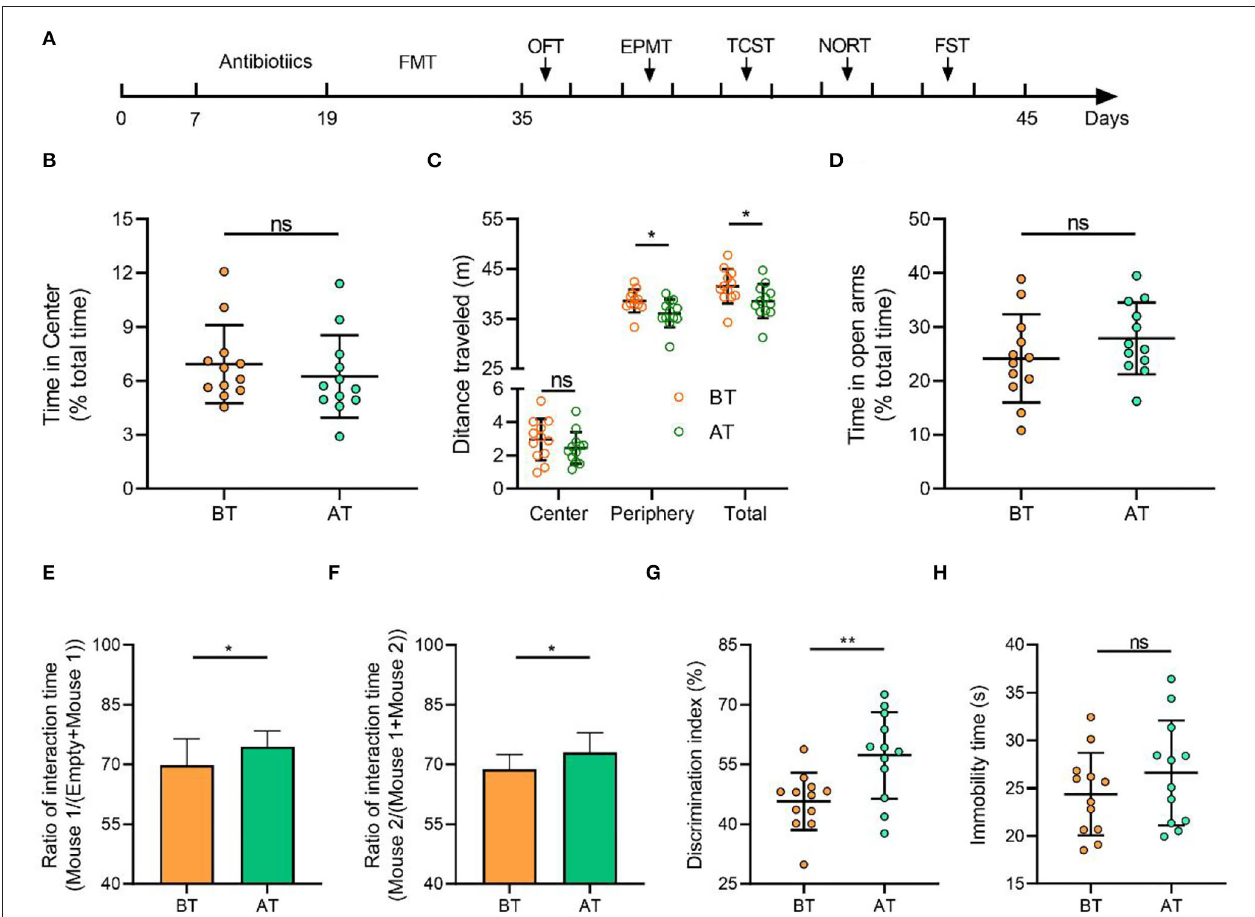
FIGURE 6 | Gut microbiota from patients with SCZ (after treatment) induced a lower level of hyperkinetic behavior and improved sociability, social novelty, and memory in mice than before treatment but had no effects on anxious state and depressive behavior. (A) Schematic diagram of mouse treatment and behavioral testing. Mice were given a cocktail of antibiotics to eliminate gut microbiota and received oral gavage of the microbiota suspension from before or after treatment patients with SCZ. A series of behavioral tests were carried out 48h after the last FMT. OFT open field test, EPMT elevated plus maze test, TCST three-chamber social test, NORT novel object recognition test, FST forced swimming test. (B) In the 10-min open field test, both groups of mice spent similar amounts of time in the central arena. (C) The cumulative distance (meters) traveled in the different zones, the representative traces of mouse activity. (D) Time in open arms of the elevated plus maze during 5-min exploration did not vary between two groups. (E) AT mice had obvious changes in sociability compared with BT mice. (F) AT mice had obvious changes in social novelty compared with BT mice. (G) Novel object recognition test. AT mice spent significantly more time exploring the novel object compared with BT mice, indicating improvement of impaired recognition memory. (H) Immobility in the forced swimming test (FST, p = 0.138) was similar between BT and AT mice. Means ± SD were presented in (B–H) and each circle represents individual mouse ( n = 12 per group). P -values were determined by the Independent Student T -test. ns, no significant. * p < 0.05, ** p <